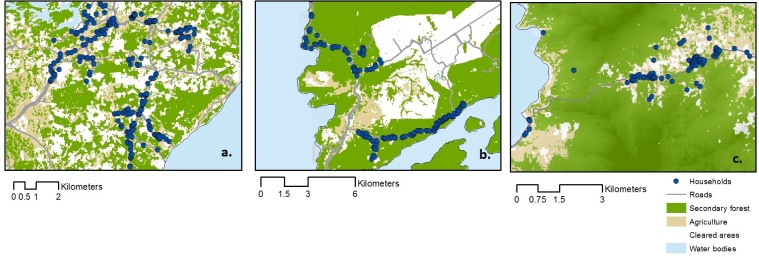
Land use classification of study sites.a. Highly deforested and fragmented site at Matunggong, Kudat, Sabah, Malaysia; b. Some forested area bordering large scale clearing in Limbuak, Pulau Banggi, Sabah, Malaysia; c. Mostly intact forest in Bacungan, Palawan, Philippines.